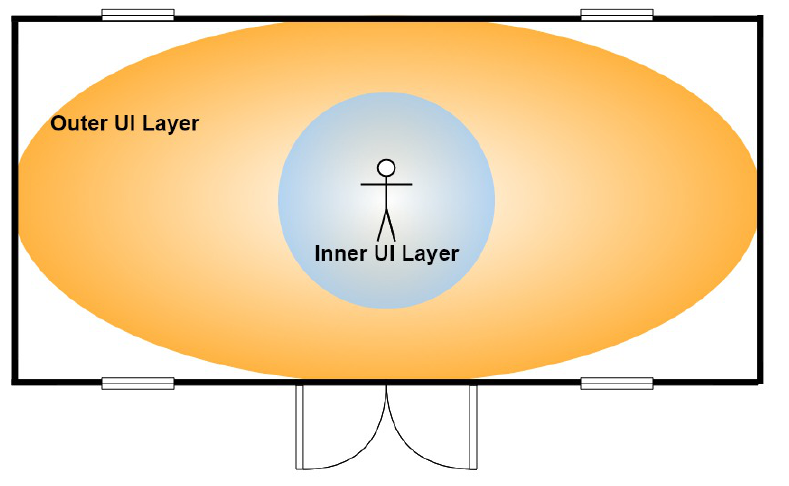
Figure 3. UI layers.